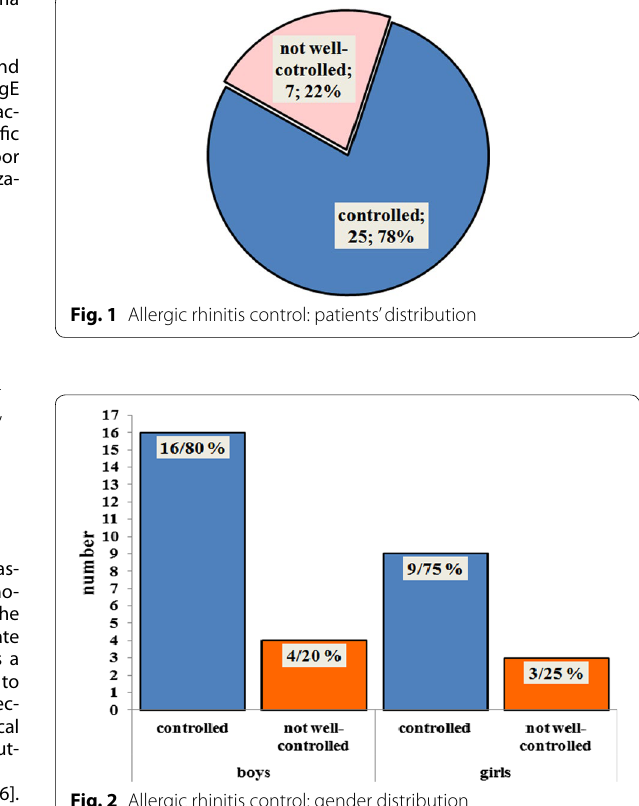
Fig. 2 Allergic rhinitis control: gender distribution